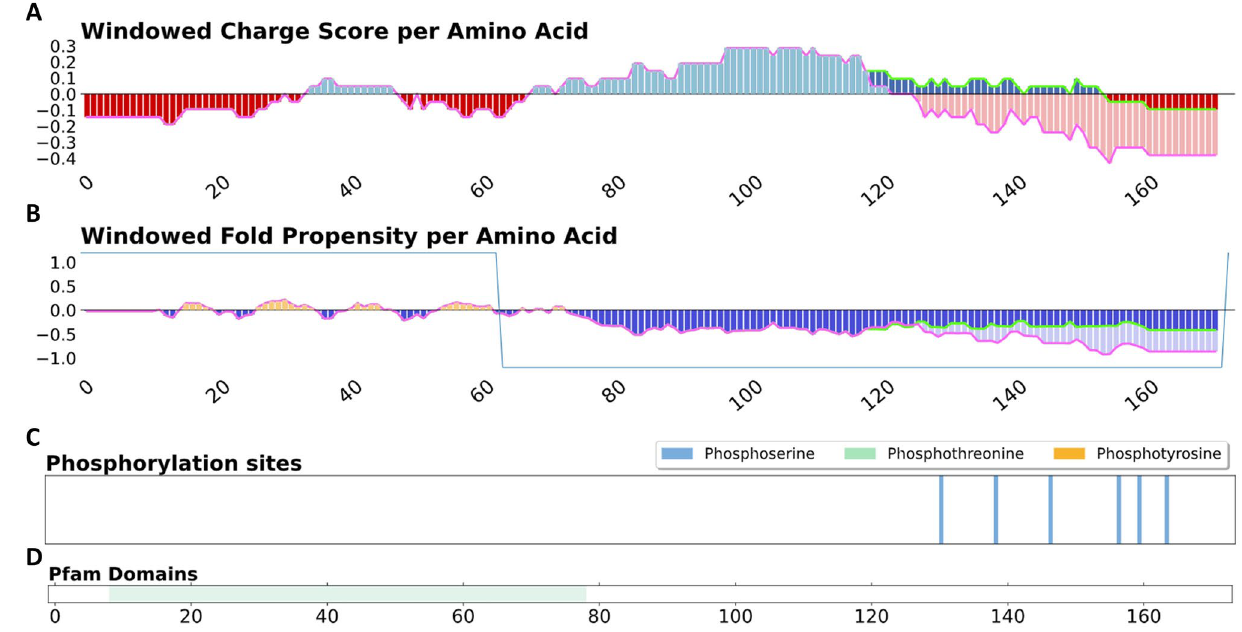
Figure 1. Results of phosIDP server for CIRBP (UniprotKB: Q14011), a stress granule-associated protein. ( A ) and ( B ) Changes to charge and fold propensity upon phosphorylation are depicted in lighter shades. Additional delineation of the profiles is given with a green line for unphosphorylated values and a pink line for phosphorylated values. The sawtooth window for smoothing disordered and ordered regions is shown in blue. ( C ) Phosphorylation sites from UniProt are displayed. ( D ) Location of known Pfam